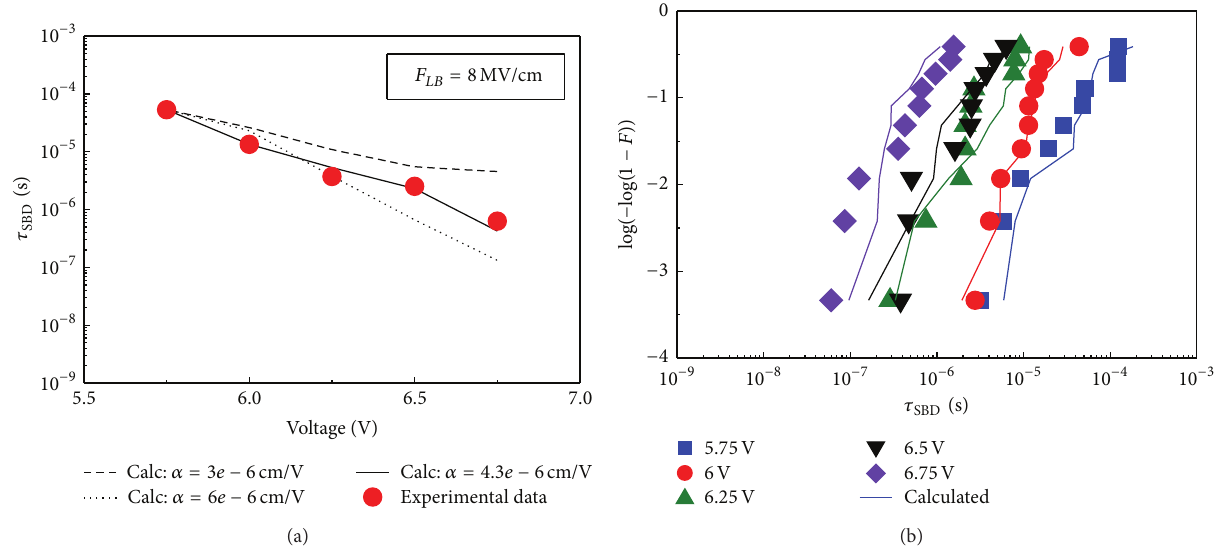
Figure 4: Comparison between experiments performed on RRAM cells of the type Pt/HfO 2 /Pt. HfO 2 and simulations: (a) measured versus 𝑉 𝑃 ; (b) measured (symbols) and calculated (lines) Weibull distributions of times to (symbols) and calculated (lines) values of 𝜏 SBD soft breakdown. The model parameters used in the simulations are 𝑓 1 = 15 %, 𝑓 2 = 10 %, 𝛼 = 4.3𝑒 −6 cm/V, and 𝐹 𝐿𝐵 = 8